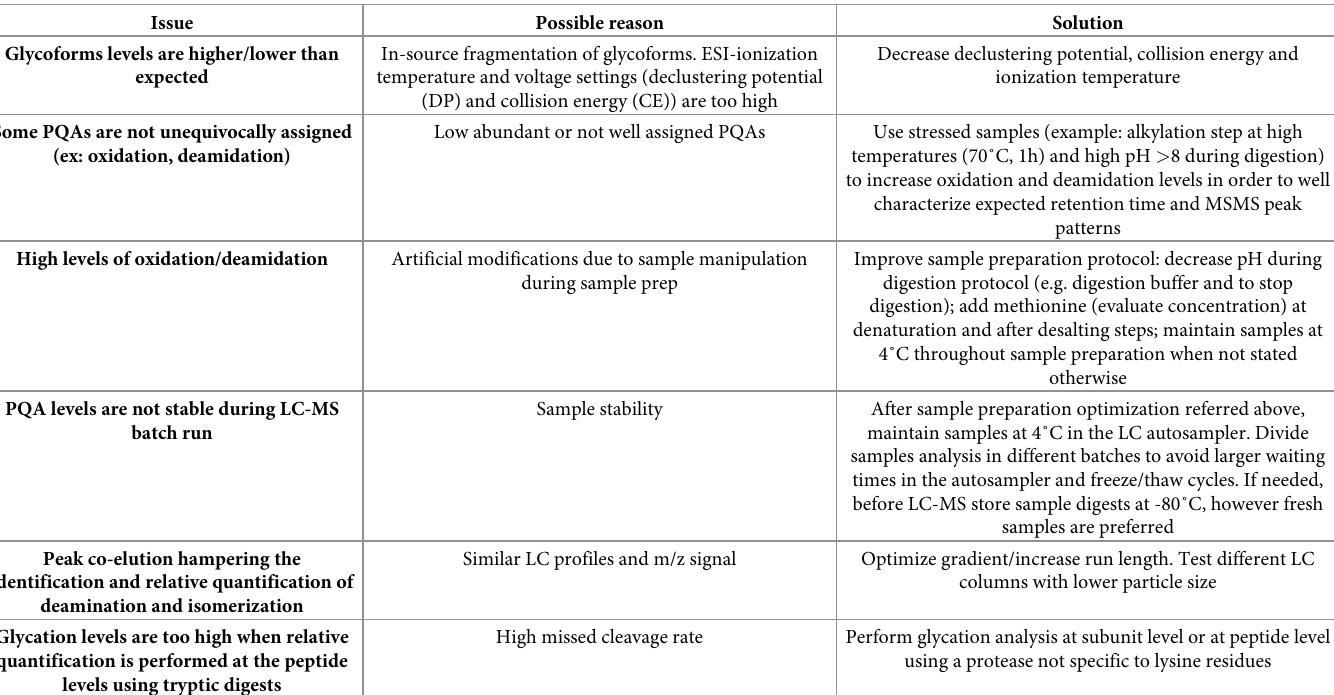
Table 5. Troubleshooting table summarizing issues found across MAM workflow implementation in this study, namely when focusing on sample batch processing. Possible reasons underlining the problems described and solution hints are also proposed.